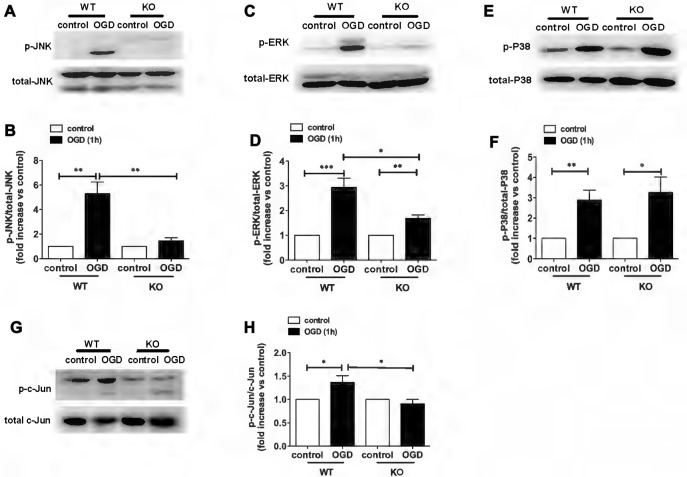
Involvement of KCa3.1 in OGD-induced phenotypic modulation of astrocytes through the ERK1/2 and JNK signaling pathways. (A,C,E) Representative images of total JNK, ERK1/2, P38 and phosphorylated JNK (p-JNK), ERK1/2 (p-ERK1/2), P38 (p-P38) in WT and KO astrocytes with or without OGD (1 h). (B,D,F) Mean values of p-JNK, p-ERK1/2 and p-P38 relative to total JNK, ERK1/2 and P38 protein (n = 3). Data are presented as means ± SEM. *p < 0.05, **p < 0.01, ***p < 0.001. (G) Representative images of total c-Jun and phosphorylated c-Jun (p-c-Jun) in WT and KO astrocytes, with or without OGD (1 h). (H) Mean values of p-c-Jun relative to total c-Jun protein (n = 3). Data are presented as means ± SEM. *p < 0.05. WT, wild type; KO, knockout; OGD, oxygen–glucose deprivation.